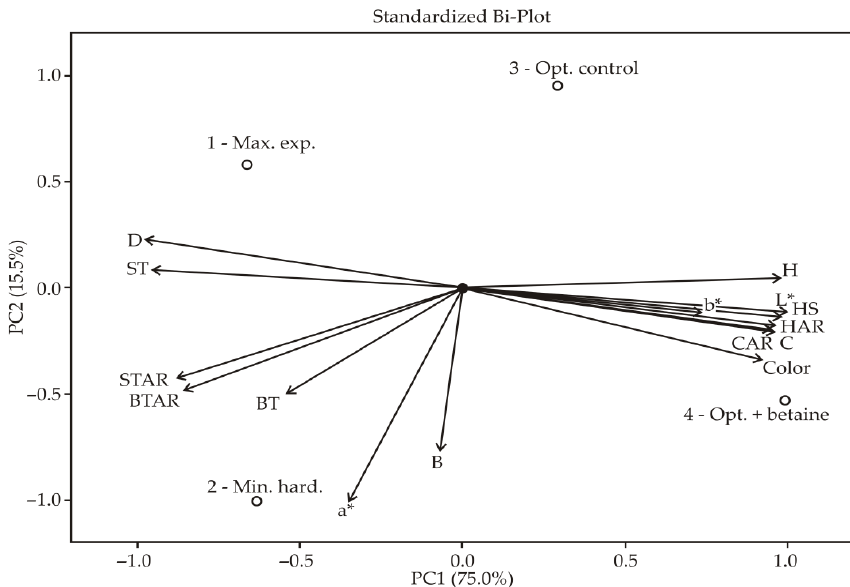
Figure 5. Linear combinations of variables identified via PCA analysis and the position of samples in the factor space (Bi-plot).